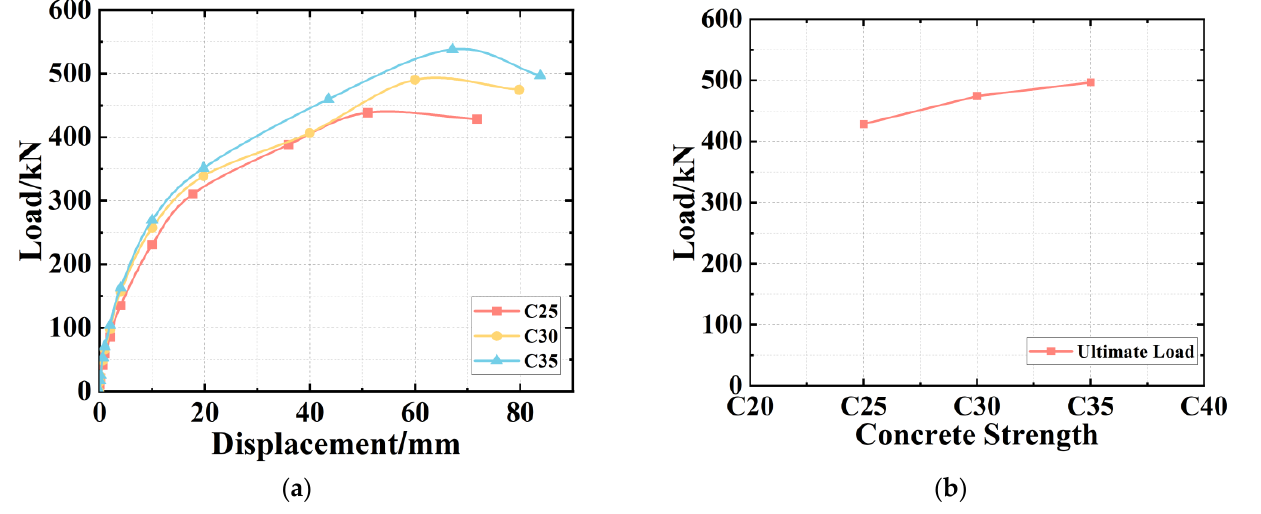
Figure 16. The Simulated Results of Different Concrete Strength. ( a ) Load – Displacement Curves. ( b ) The Ultimate Load.